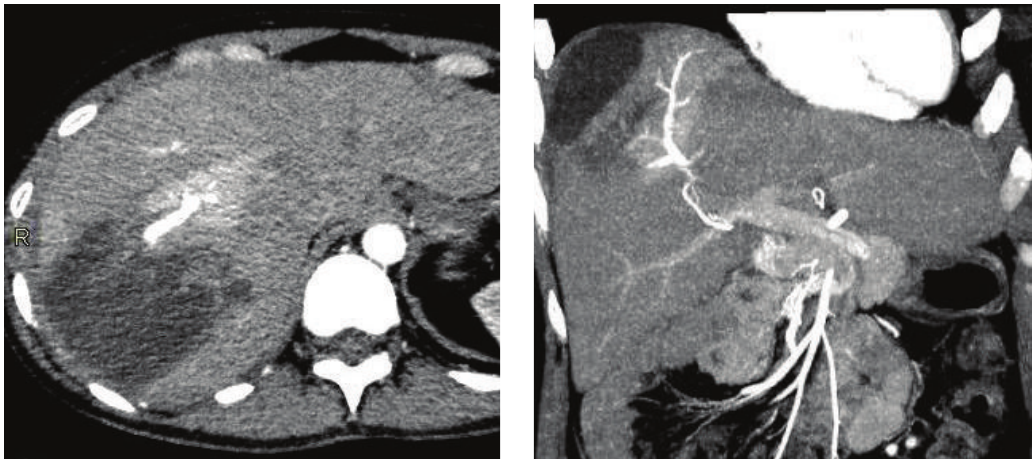
Figure 2: Follow-up CT performed 13 days after the injury. Enhanced CT reveals an arterioportal fistula in segment 8 of the liver with partial enhancement of the liver parenchyma in the early